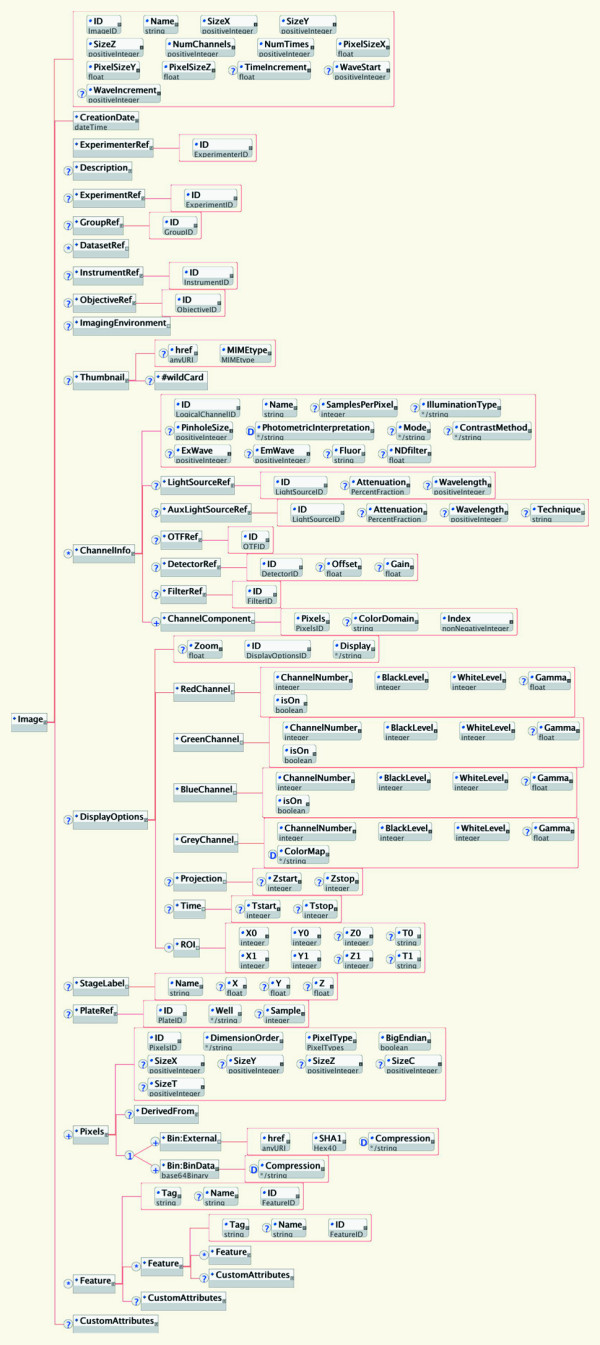
The Image element in the OME file schema. The data elements that define the an image in the OME file are shown. These include the image itself (Pixels), and a variety of characteristics of the image data and display parameters. Symbols are as in Figure 2.